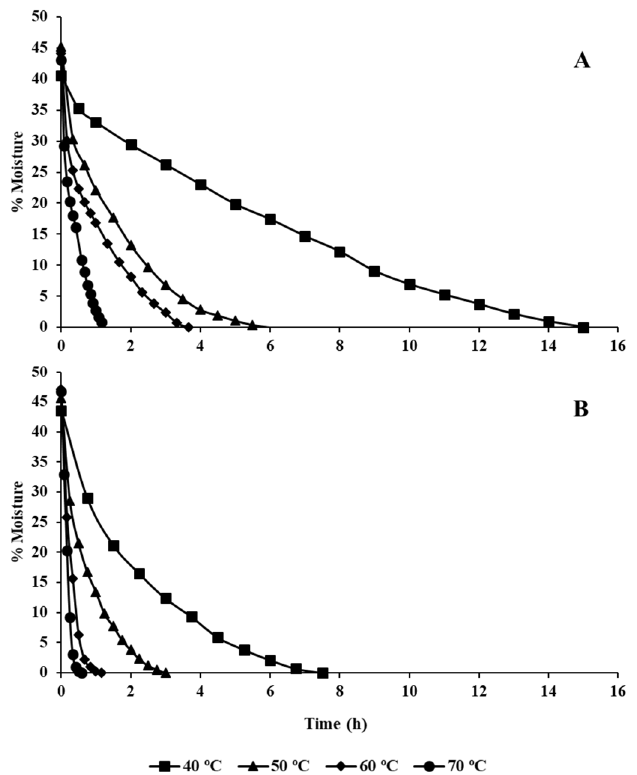
Figure 1. Relationship between the percentage of moisture (%) and drying time (h) at different temperatures. Panel ( A ): drying in the oven. Panel ( B ): drying in the infrared equipment.